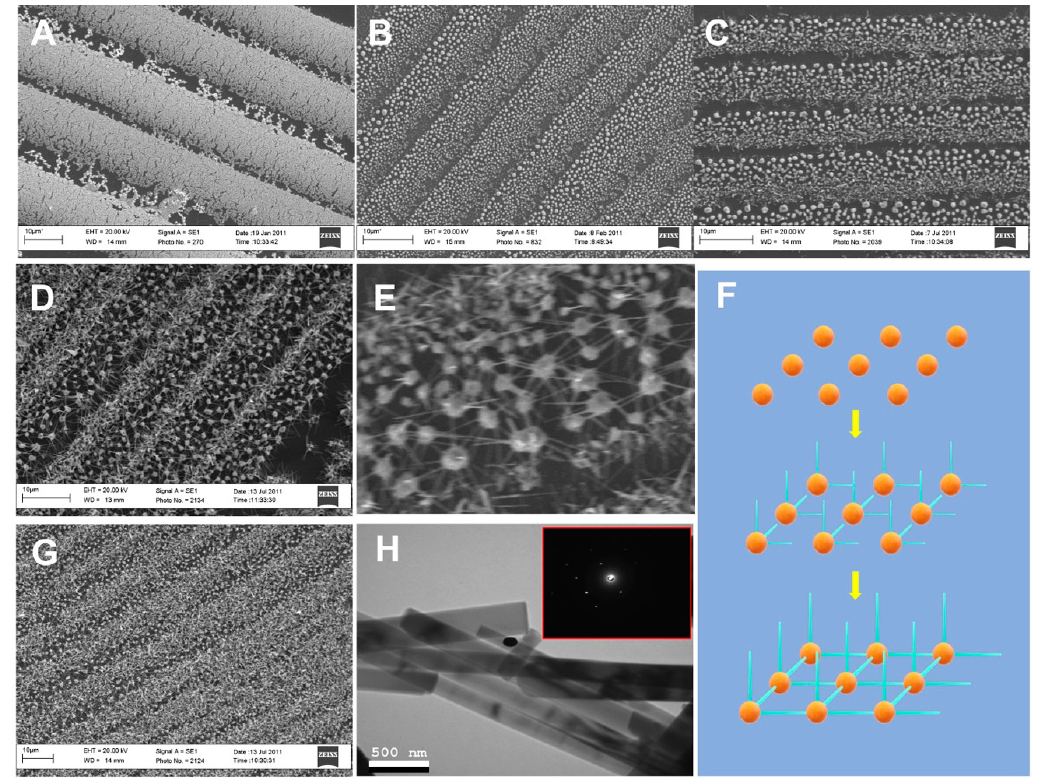
Figure 2. ( A ) Scanning electron microscope (SEM) image of gold nanobelts. ( B ) SEM image of gold nanobelts after annealing at 1100 °C. ( C ) SEM image of the Au–ZnO network after 2 min and ( D ) 15 min of growth. ( E ) Higher magnification of the Au–ZnO network. ( F ) SEM image of Au–ZnO (M-S) n nanostructures grown at 20 min. ( G ) SEM images of Au–ZnO (M-S) n nanostructures grown at 30 min. ( H ) Transmission electron microscope (TEM) images of ZnO nanowires from the Au–ZnO network. The insets show electron diffraction patterns. The black dots are imaging artifacts. Sensors 2019 , 19 , x FOR PEER REVIEW